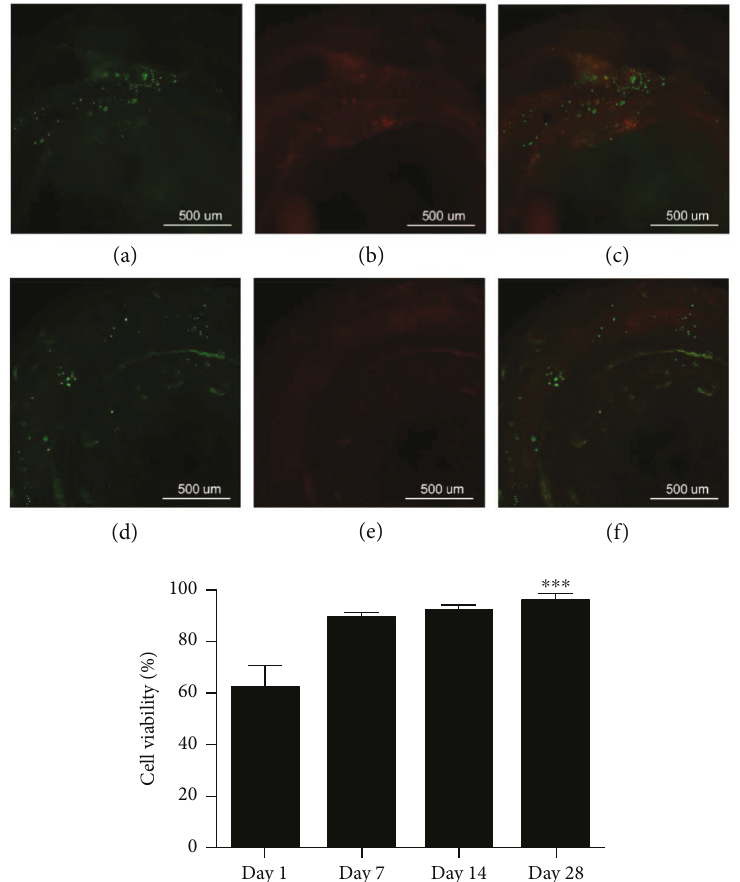
Figure 6: Time course of the live cell ratio using the Live/Dead assay. The pumped tube at day 1 had some dead cells (red) (a – c) while these dead cells decreased by day 28 (d – f). Cell viability was increased during day 1 to day 7 periods. Error bars indicate the SD. ∗∗∗ P < 0 001